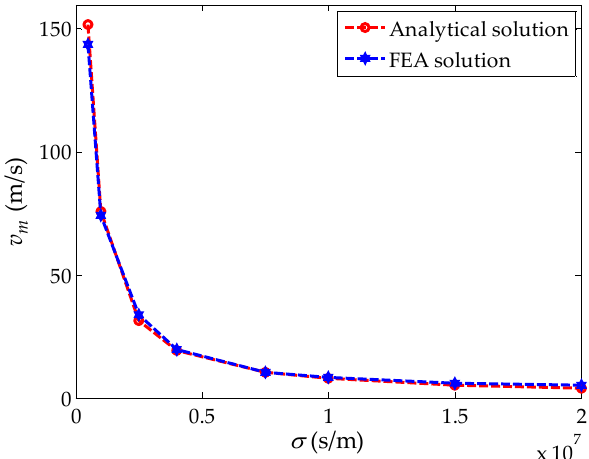
Figure 14. The critical speed varying with the induction plate conductivity.